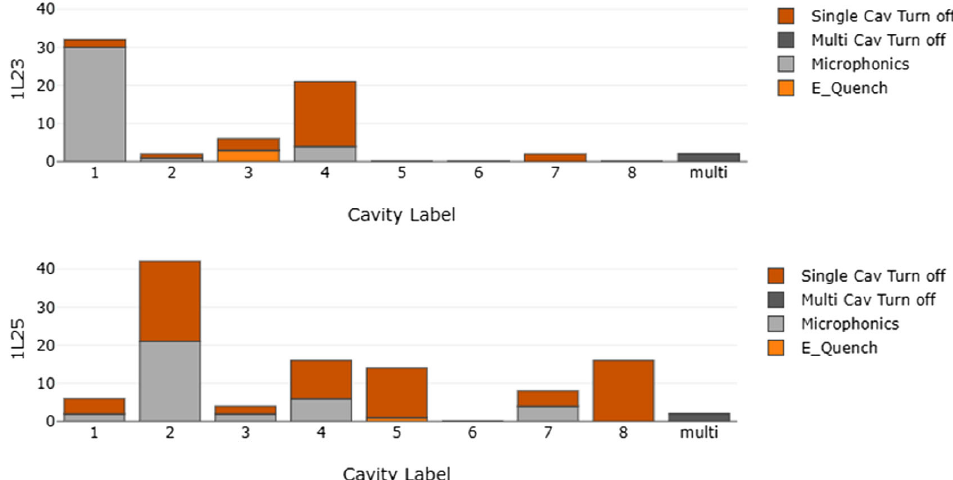
FIG. 8. Partial screenshot showing a graphical summary of machine learning model predictions. Each plot window provides information about the number of faults for an individual cryomodule (vertical axis). Fault types are color coded and displayed for each of the eight cavities (horizontal axis).